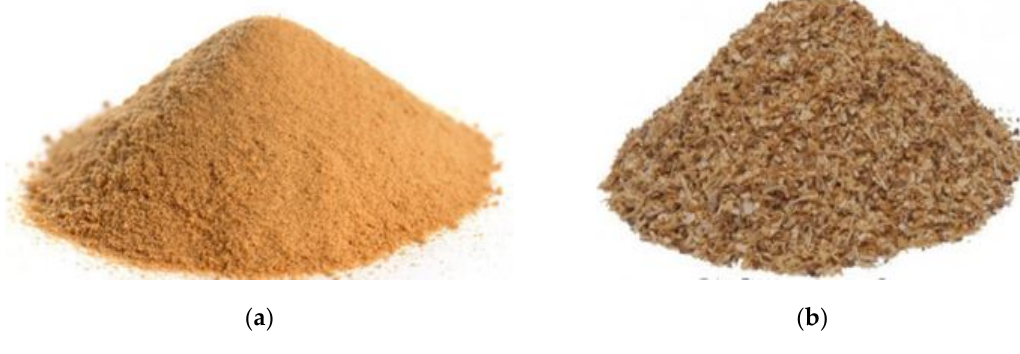
Figure 2. ( a ) Fine sawdust, ( b ) coarse sawdust.